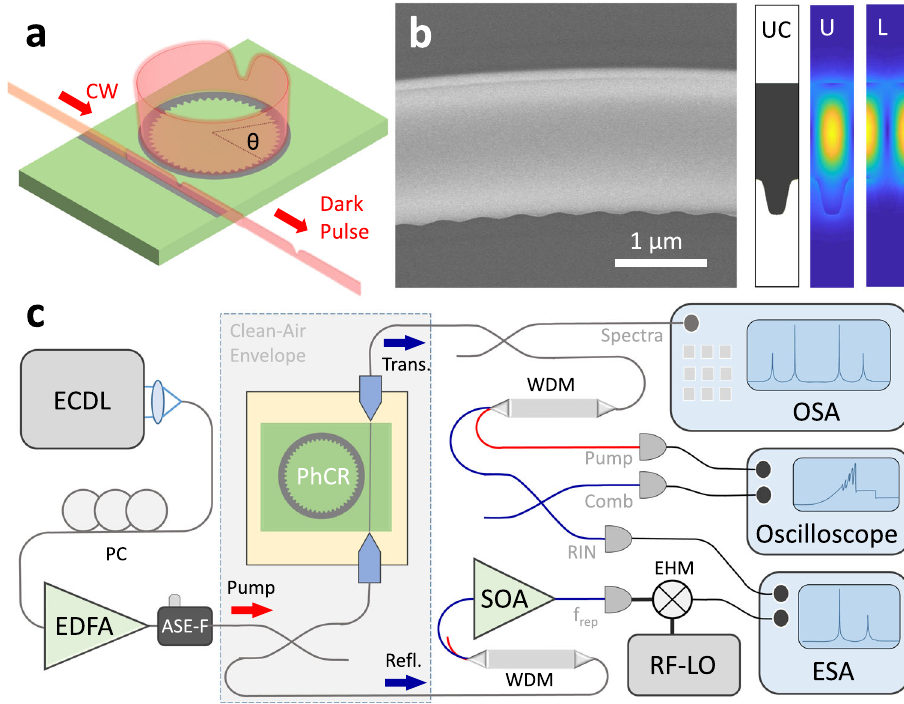
Fig. 3 Experiment protocol. a Illustration of dark pulse generation in the PhCR. b Electron microscopy image showing a section of the PhCR. The unit cell (UC) is shown on the right with exaggerated modulation for clarity. The right-most panels show simulated electric fi eld distributions for the (U) upper and (L) lower modes. c Diagram showing the optical testing setup. ECDL: external-cavity diode laser, EDFA: erbium-doped fi ber ampli fi er, ASE-F: ampli fi ed spontaneous emission fi lter, WDM: wavelength-division multiplexer, SOA: semiconductor optical ampli fi er, EHM: even harmonics mixer, LO: local oscillator, OSA/ESA: optical/electronic spectrum analyzer.